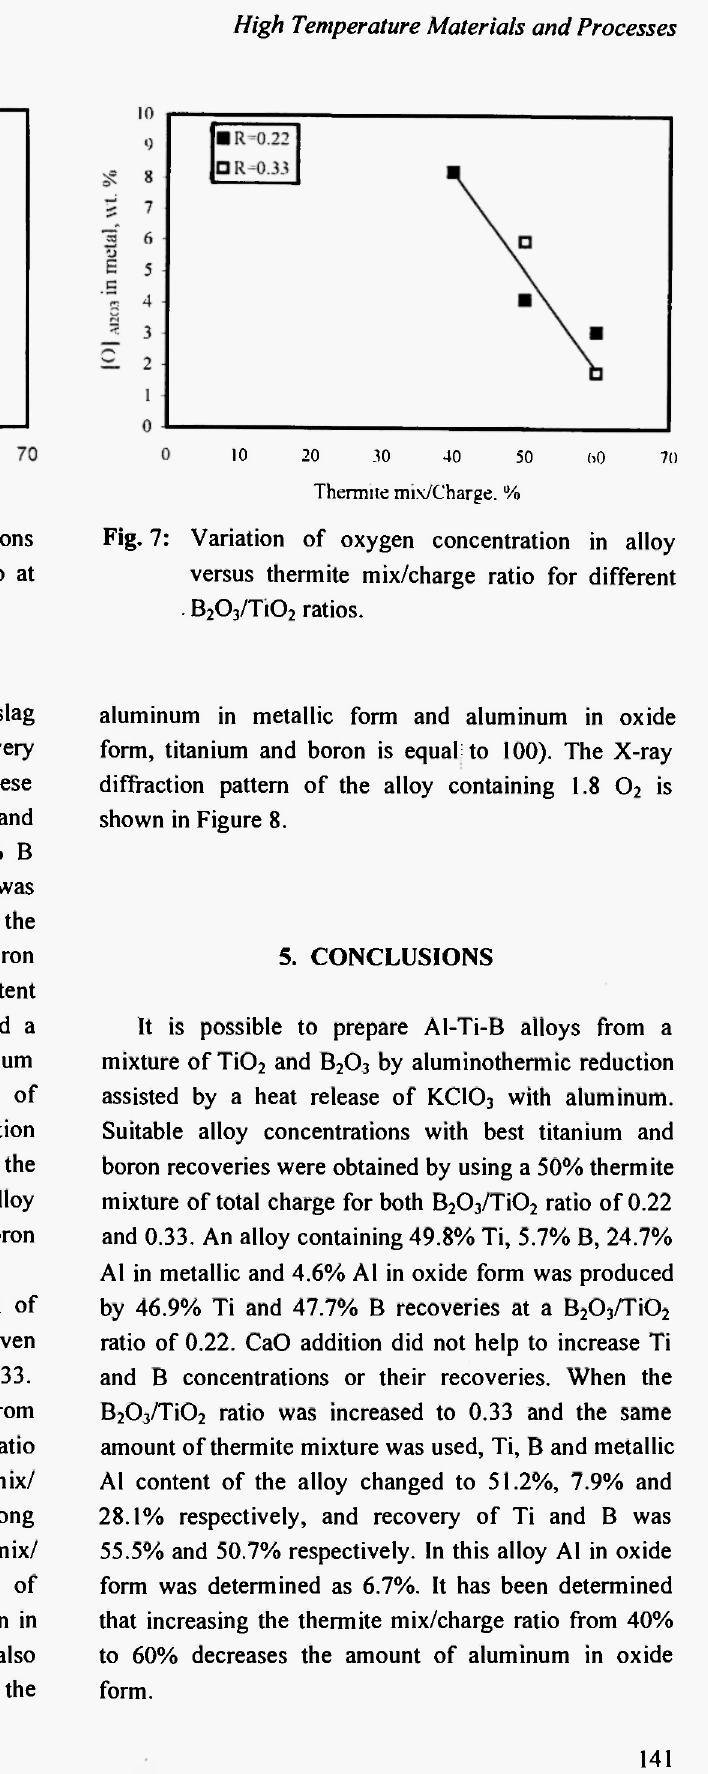
Fig. 6: Changes in titanium and boron concentrations in alloy with the thermite mix/charge ratio at the Β 2 0 / Π 0 2 ratio of 0.33.